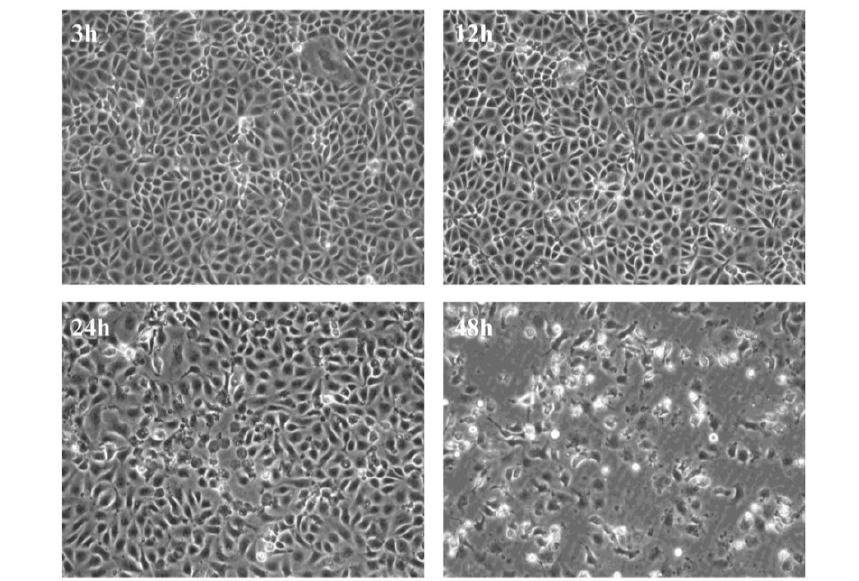
Figure 1. Cytopathic effects in CHSE cells . Development of cytopathic effect in CHSE-214 cells infected with recombinant strain rNVI-15R b of infectious pancreatic necrosis